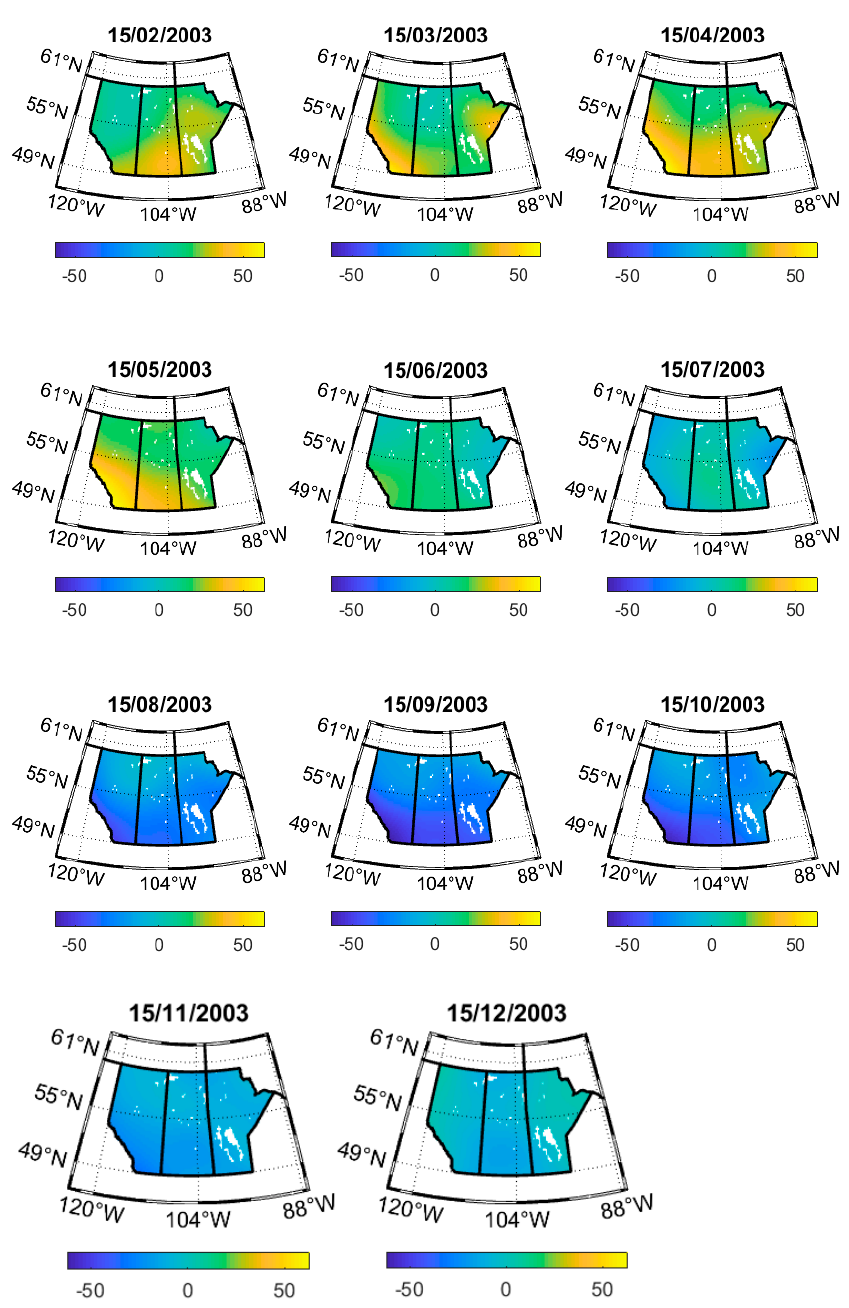
Figure 6. GRACE terrestrial water storage anomalies (TWSA) after downscaling on the 15th day of each month between February and December 2003 [mm].